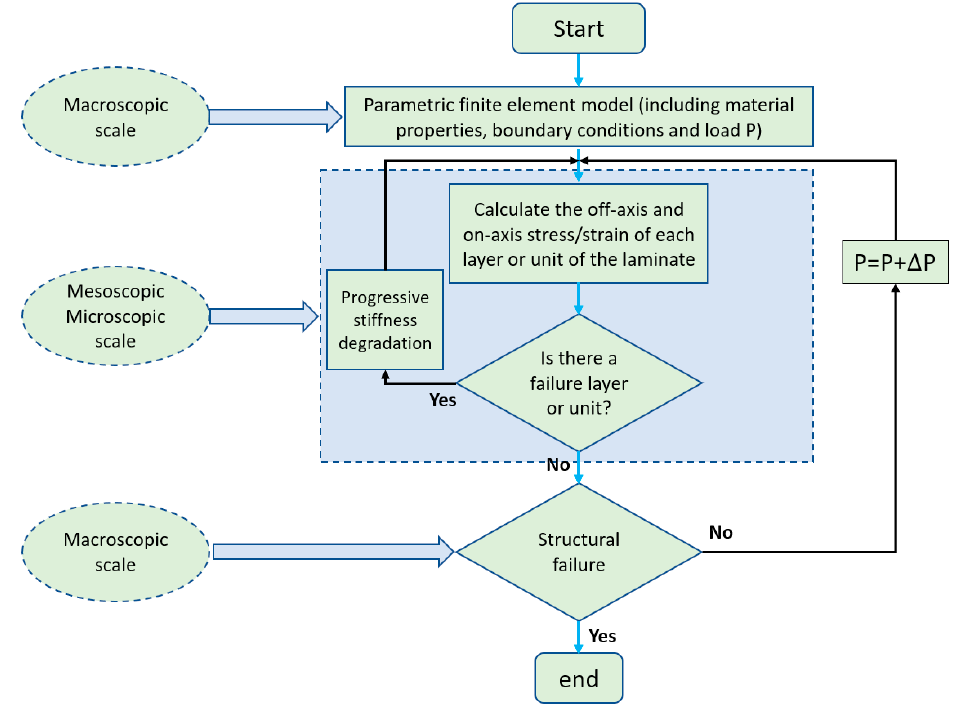
Figure 19. The flow chart of the progressive failure analysis [38].